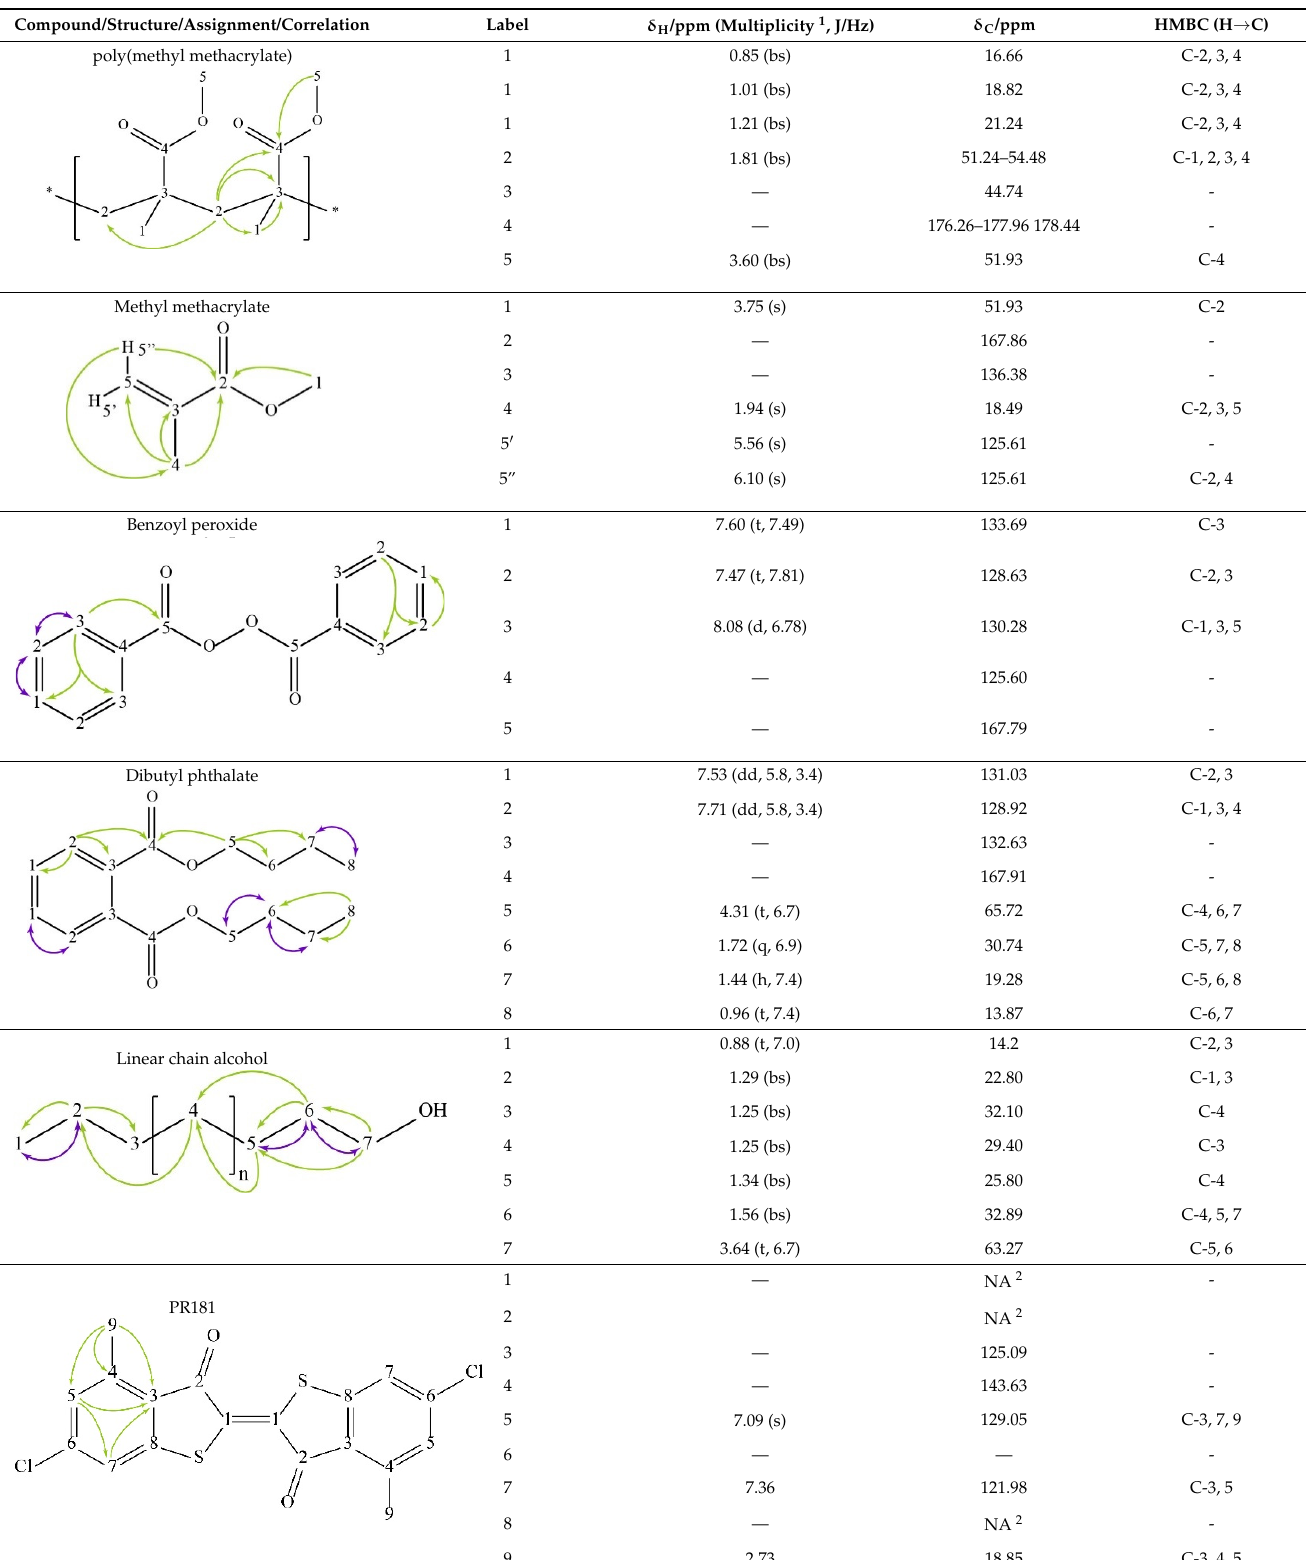
Table 1. Spectroscopic data (700 MHz, CDCl 3 ) of compounds identified in Paisaje Abstracto sample. Arrows in green indicate key HMBC correlations and in purple indicate key COSY correlations.